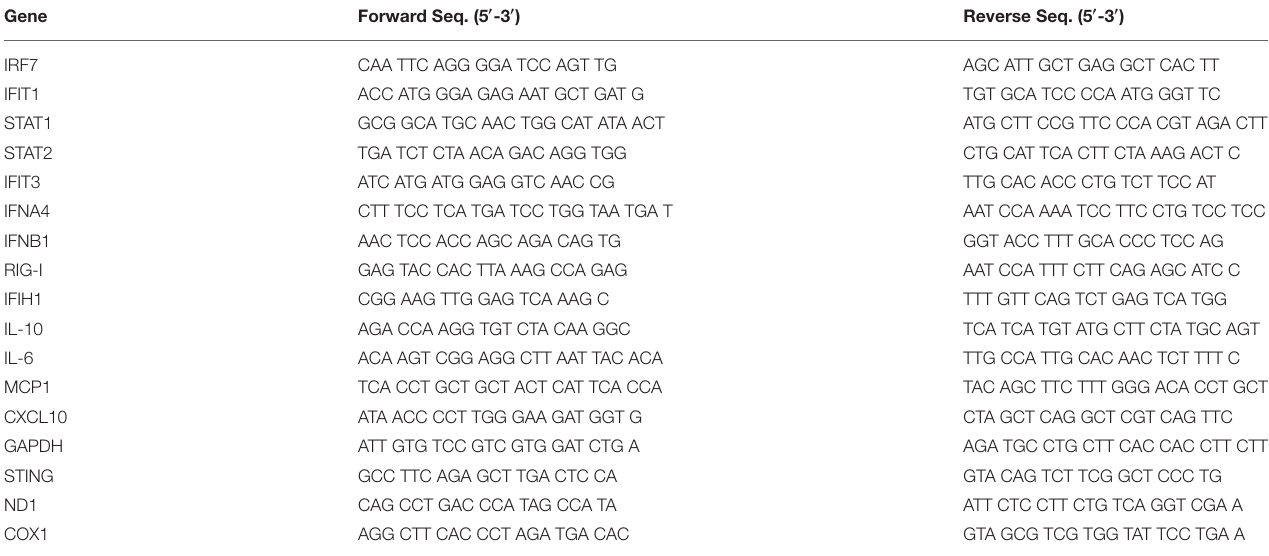
List of forward and reverse sequences used for